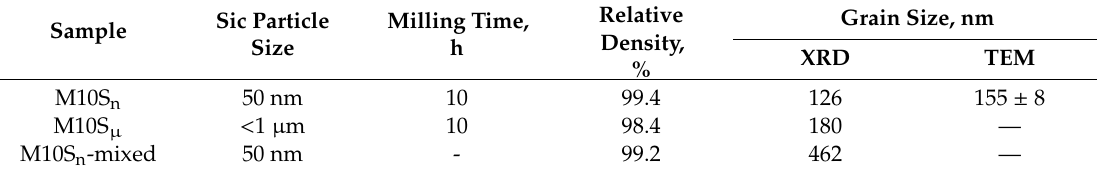
Table 1. SiC particle size, relative density, and average grain size of the extruded Mg composites.